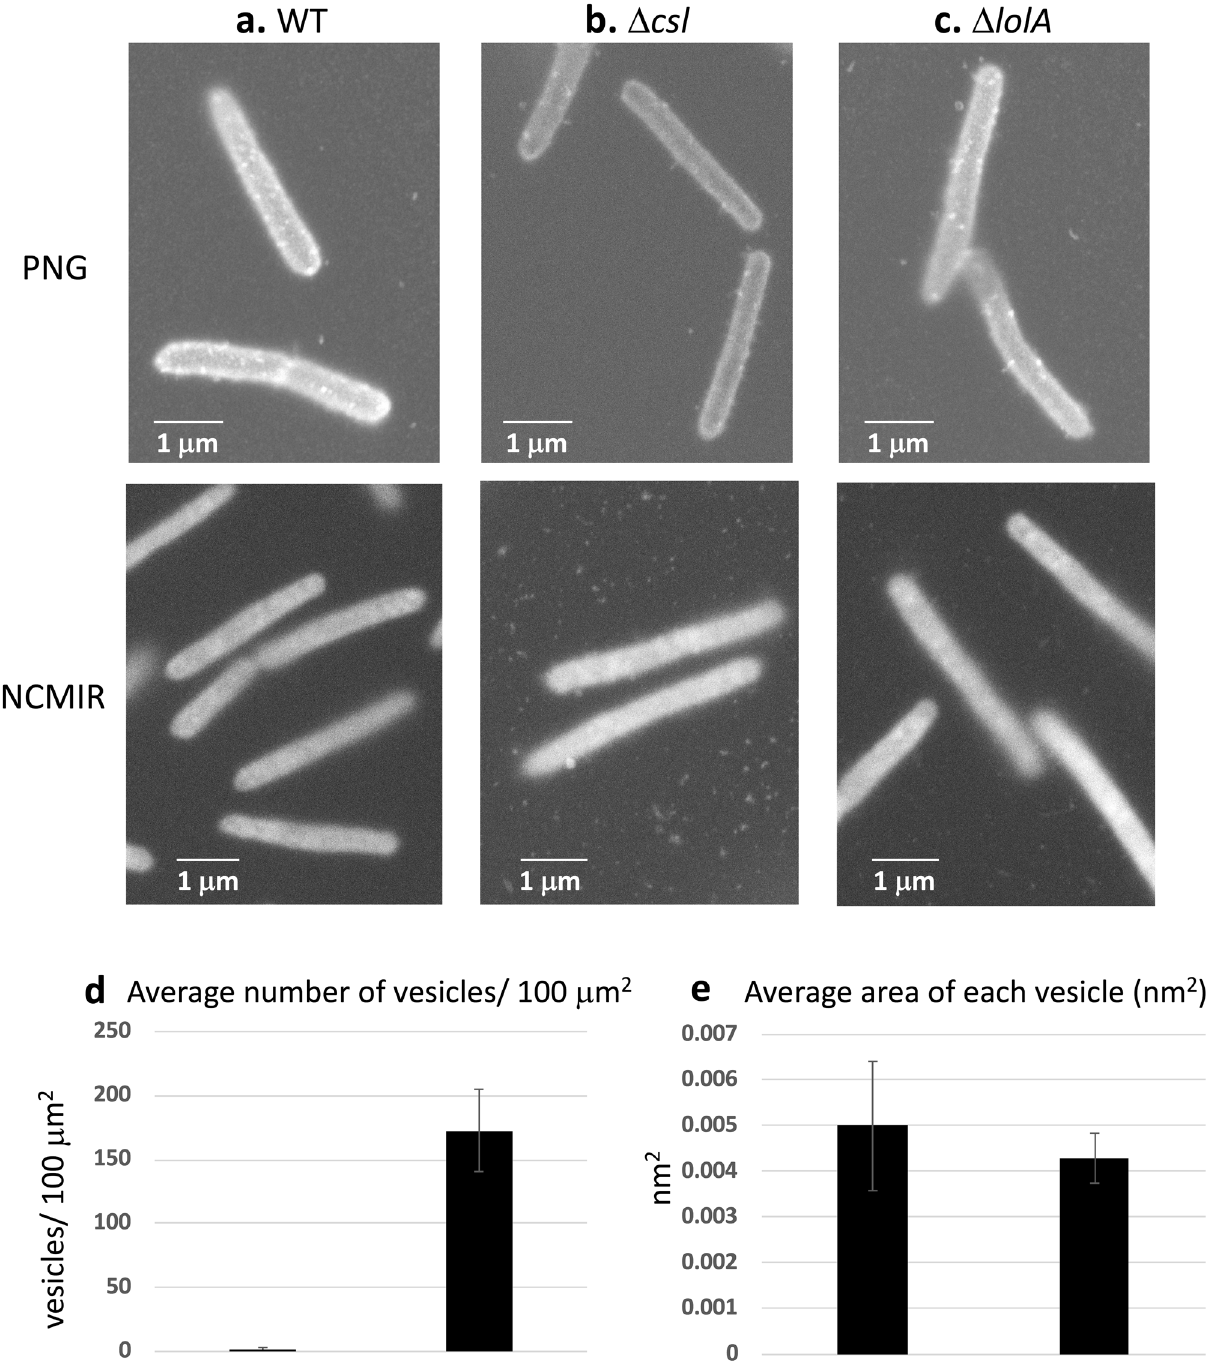
Figure 7. ASEM images of F. johnsoniae . Cells were cultured in CYE (casitone-yeast extract) liquid medium directly on the SiN film of an ASEM dish, fixed with paraformaldehyde and glutaraldehyde, and stained as described in the methods section 14 . The cells were immersed in glucose solution and observed using ASEM. ( a ) WT, ( b ) Δ csl , ( c ) Δ lolA . Upper panels, positively charged Nanogold-labeled cells; lower panels, Nanogold-labeled cells counterstained by the NCMIR method to visualize vesicles. Both the outer membranes and filaments 200 nm in length were clearly imaged for all of the cells. Scale bar 1 μm. ( d ) The polulation density of vesicles (vesicles/100 μm 2 ) was measured. More vesicles were released from Δcsl cells than from WT cells (Fig. S8). ( e ) The area of vesicles (nm 2 ) was measured. Vesicles released from Δcsl cells were almost the same size as vesicles released by the WT. The error bars on the graph correspond to the